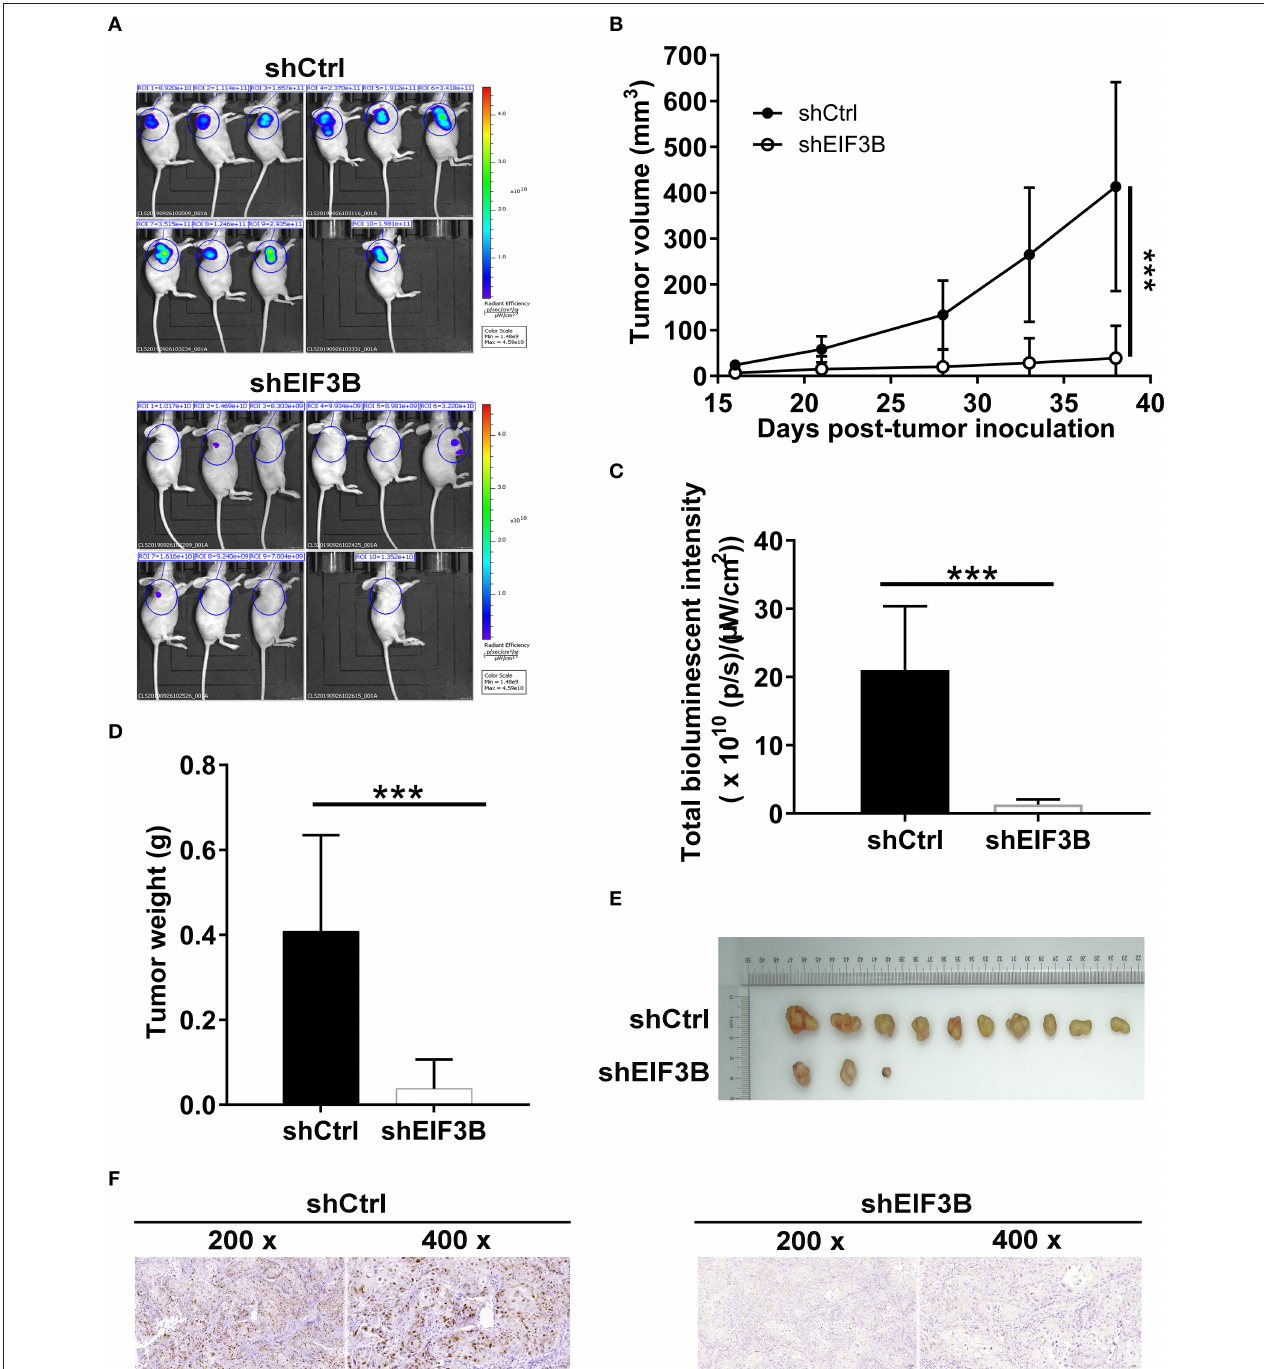
FIGURE 5 | Eukaryotic translation initiation factor 3 subunit B (EIF3B) knockdown suppressed pancreatic cancer (PC) growth in vivo . (A) A nude mice model of EIF3B knockdown was constructed. (B) The volume of tumors was tested from feeding to sacrifice. (C) The fluorescence intensity was obtained through injection of D-Luciferase before sacrificing the mice. (D) The weight of tumors was measured after sacrificing the mice. (E) The photograph of tumors was taken after removing tumors. (F) The value of Ki-67 was detected by immunohistochemistry (IHC) in tumor sections. Results are presented as mean ± SD. *** P < 0.001. was reported that EIF5A inhibition had anti-tumorigenic effects more effective treatment of PC. Suppressing the expression of on leukemia cells when given either alone or in combination EIF3B or interrupting its signaling pathways may prevent or even reverse the process of tumor development. On the other hand, it with imatinib. Besides, the EIF5A protein has been used to